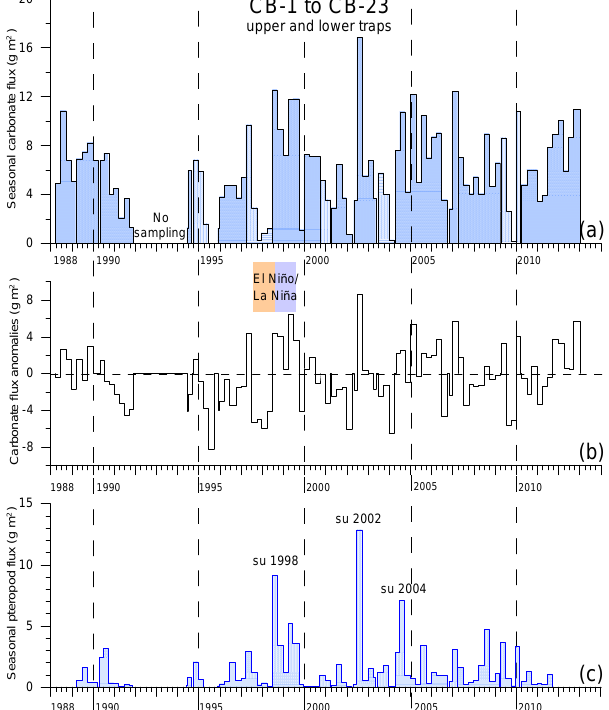
Figure 10. (a) Seasonal flux of total carbonate (blue) with gaps filled from the upper trap data (light blue bars). Deviations from the long-term seasonal means (anomalies, b ). (c) Seasonal flux of pteropods. During the strongest ENSO cycle 1997–2000, longer pe- riods of low and high carbonate fluxes occurred. Note the episodic sedimentation pattern of pteropods with maxima e.g. in sum- mer 1998, 2002 and 2004. The strong ENSO cycle 1997–1999 with a warm El Niño and a cold La Niña phase is